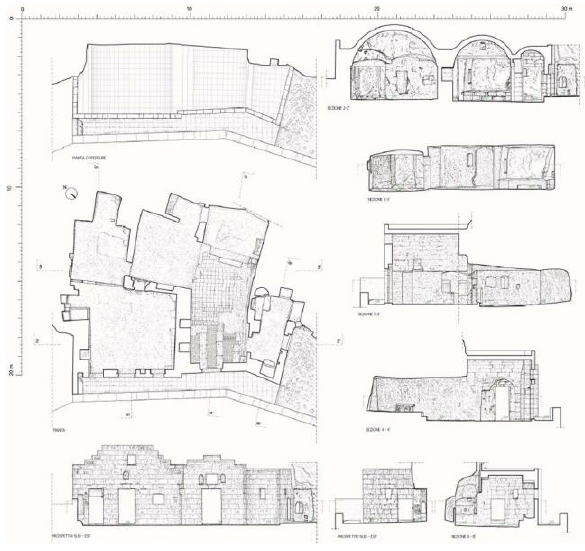
Figure 7. Plans, sections and elevations